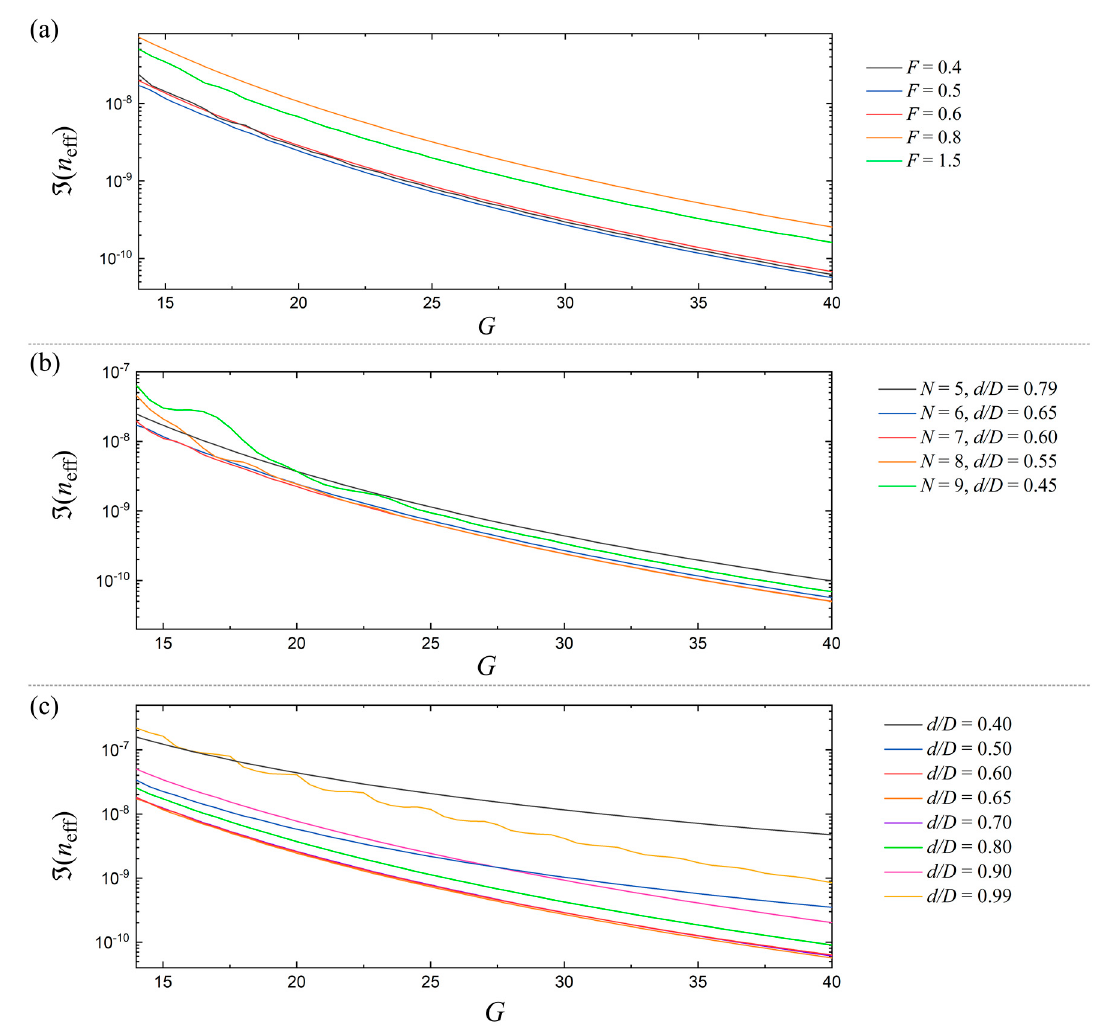
Figure 5. (cid:61) ( n eff ) versus G in THCF for different structural parameters. ( a ) For F = 0.4, 0.5, 0.6, 0.8, 1.5, while N = 6 and d / D = 0.65. ( b ) For N = 5, 6, 7, 8, 9, while F = 0.5 and d / D is set at a value that gives low loss in each N as identified in Reference [15]. ( c ) For d / D = 0.4, 0.5, 0.6, 0.65, 0.7, 0.8, 0.9, 0.99, while N = 6 and F = 0.5.